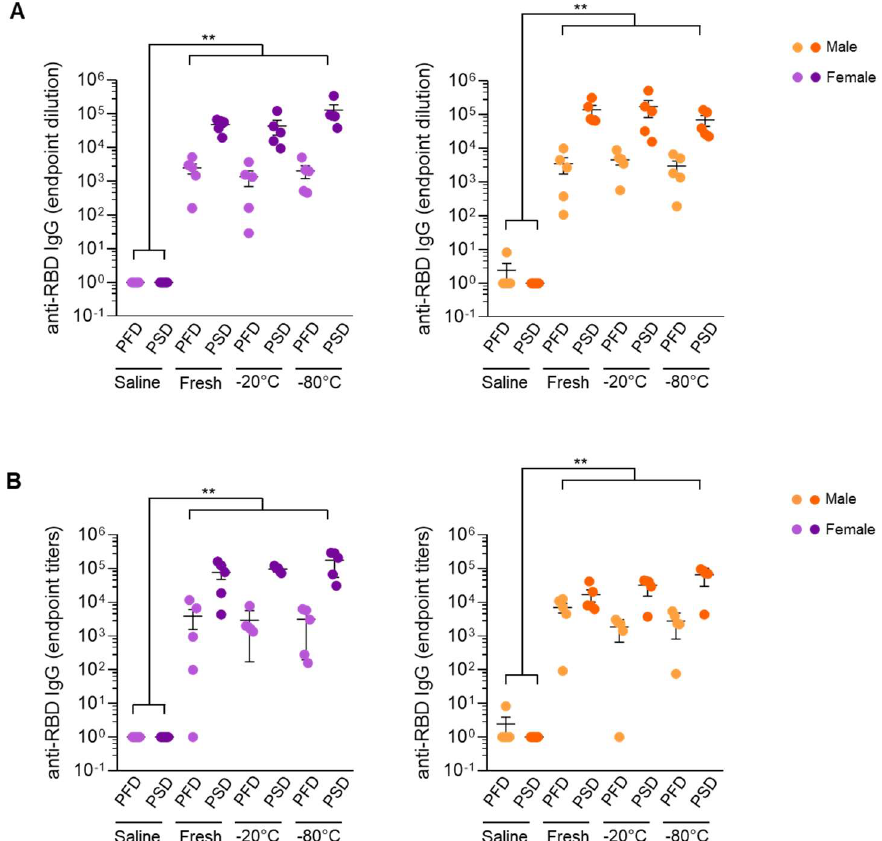
Figure 6. mRNA vaccines under different handling and re-freezing conditions induced similar responses in male and female mice. SARS-CoV-2 Spike RBD-specific IgG end-point titers of mice immunized with Comirnaty ® (Pfizer-BioNTech) vaccine ( A ) or Spikevax ® Moderna vaccine ( B ) post- prime and post-boost immunization. Sera from control mice inoculated with PBS were used to establish negative threshold values defined as the mean plus 4 times the standard deviation of the mean. Bars represent mean ± standard error mean (SEM). Dashed line indicates negative threshold. Data are presented as individual dots. Two-tailed Mann–Whitney U test was performed to compare vaccine treatment groups (saline, fresh, −20 °C, and −80 °C) (** p < 0.01). For each time point and condition, n = 5.